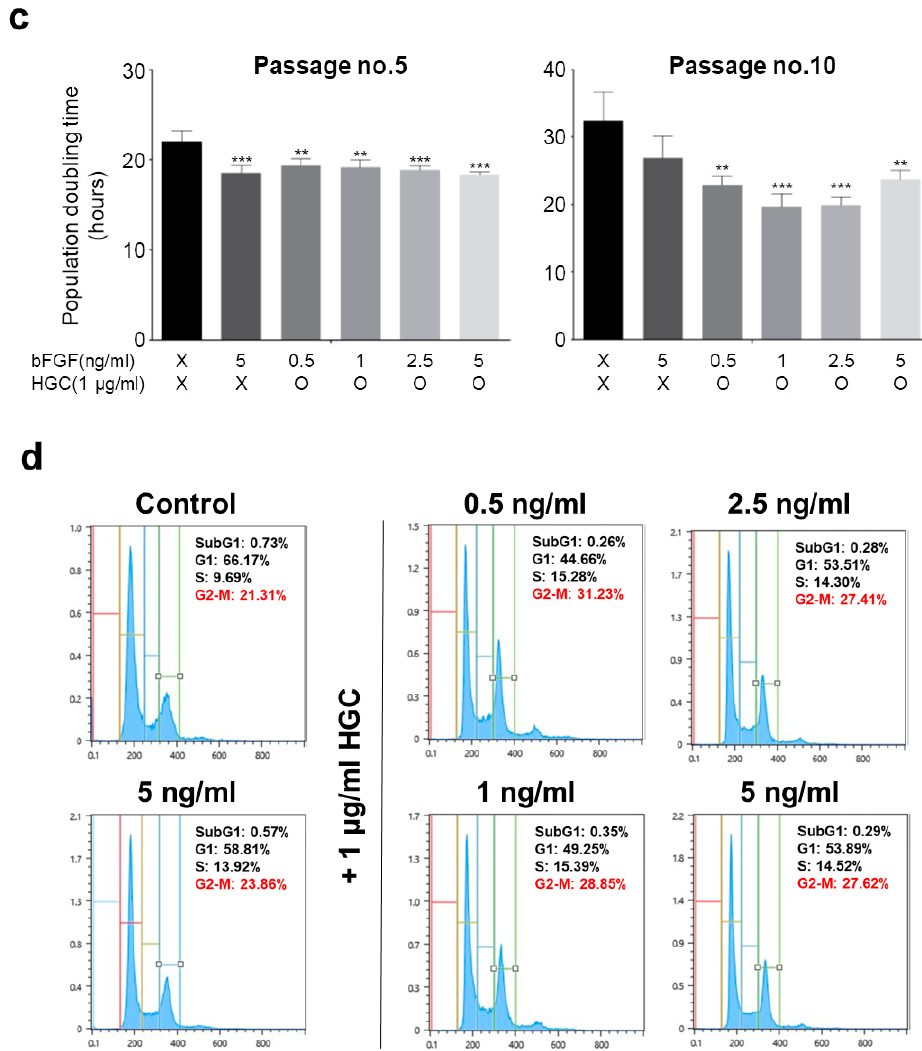
Figure 4. Comparison of proliferative capacity between HGC combined with basic fibroblast growth factor (bFGF) groups and non-treated groups. ( a ) Experimental scheme following various concentration of bFGF treatment with 1 μ g/mL of HGC; ( b ) Daily incubated cell morphology picture of AD-MSCs at passage 5; ( c ) Population doubling time at passages 5 and 10; and ( d ) cell cycle analysis. ** p < 0.01, and *** p < 0.001 relative to the control.